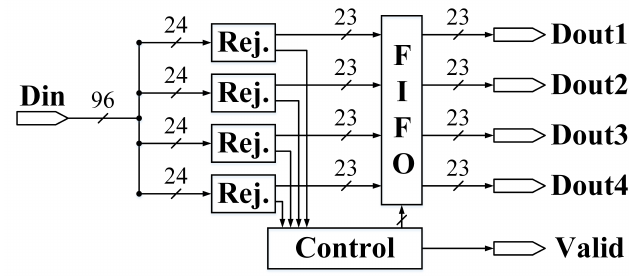
Figure 13: Block graph of the rejection sampling